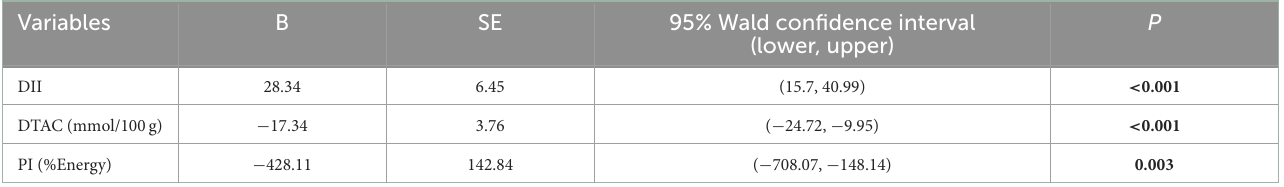
TABLE 5 Linear regression model using the GEE method for assessing the association of DII, DTAC, and PI with F 2a -IP in all participants.